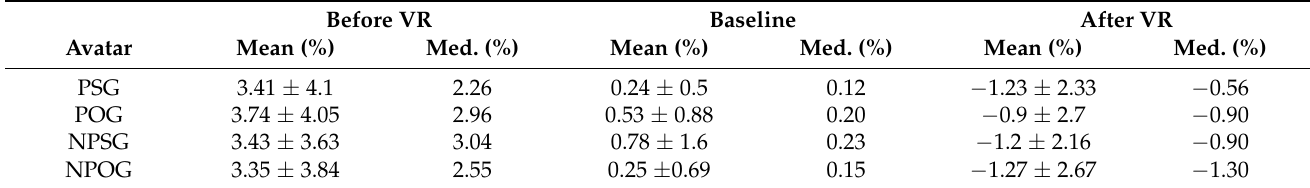
Table 3. Difference of mean temperature of each avatar and the different segment of the study. The average temperature of the segment was used as the base value.